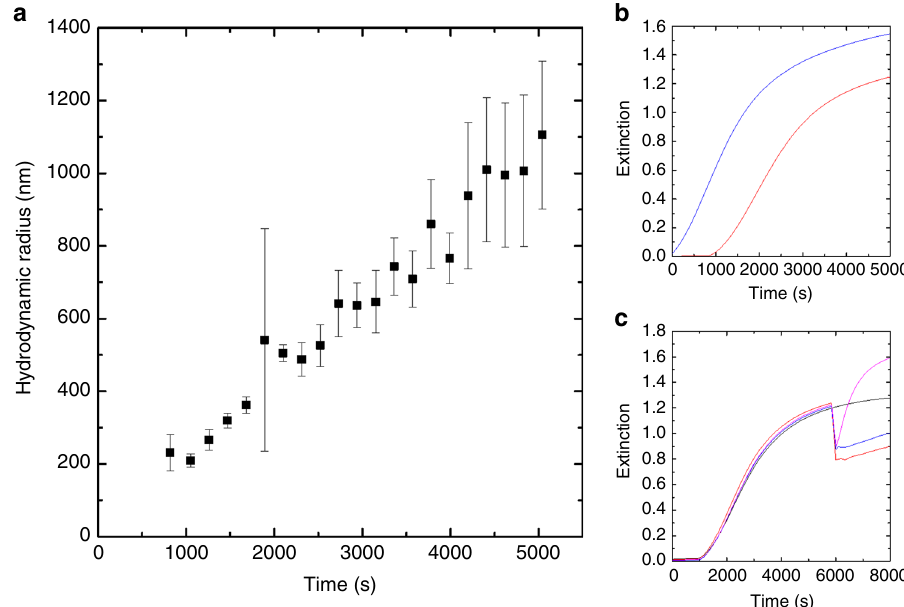
Fig. 5 Characterization of Hz-catalyzed precipitation polymerizations of NIPAAm. a Dynamic light scattering analysis of particle size for a polymerization catalyzed by 25 ng mL − 1 sHZ (mean values determined as described in the experimental section, SD). b Comparison of polymerizations catalyzed by 100 ng mL − 1 sHz purged with argon (blue) and conducted under normal conditions (red). c Effect of the addition of reagents during the plateau phase of the polymerization catalyzed by 100 ng mL − 1 sHz (at 5500 s): typical experiment (black), addition of initiator (50 µ L of a 0.375 M HEBIB solution) (red), addition of monomer and reducing agent (200 µ L of a 1.096 M NIPAAm and 0.110 mM NaAsc solution) (blue) and addition of biocatalyst (49.3 µ L of a 2.03 µ g mL − 1 sHz solution) (pink). The decrease in extinction after the addition of the reagents is the consequence of the dilution of the reaction mixture